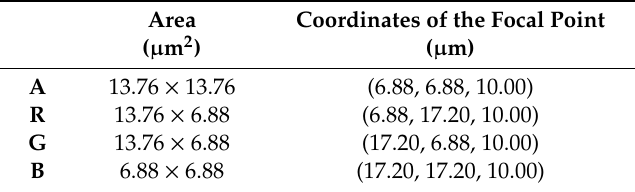
Table 3. Design parameters of four areas with unequal proportions.